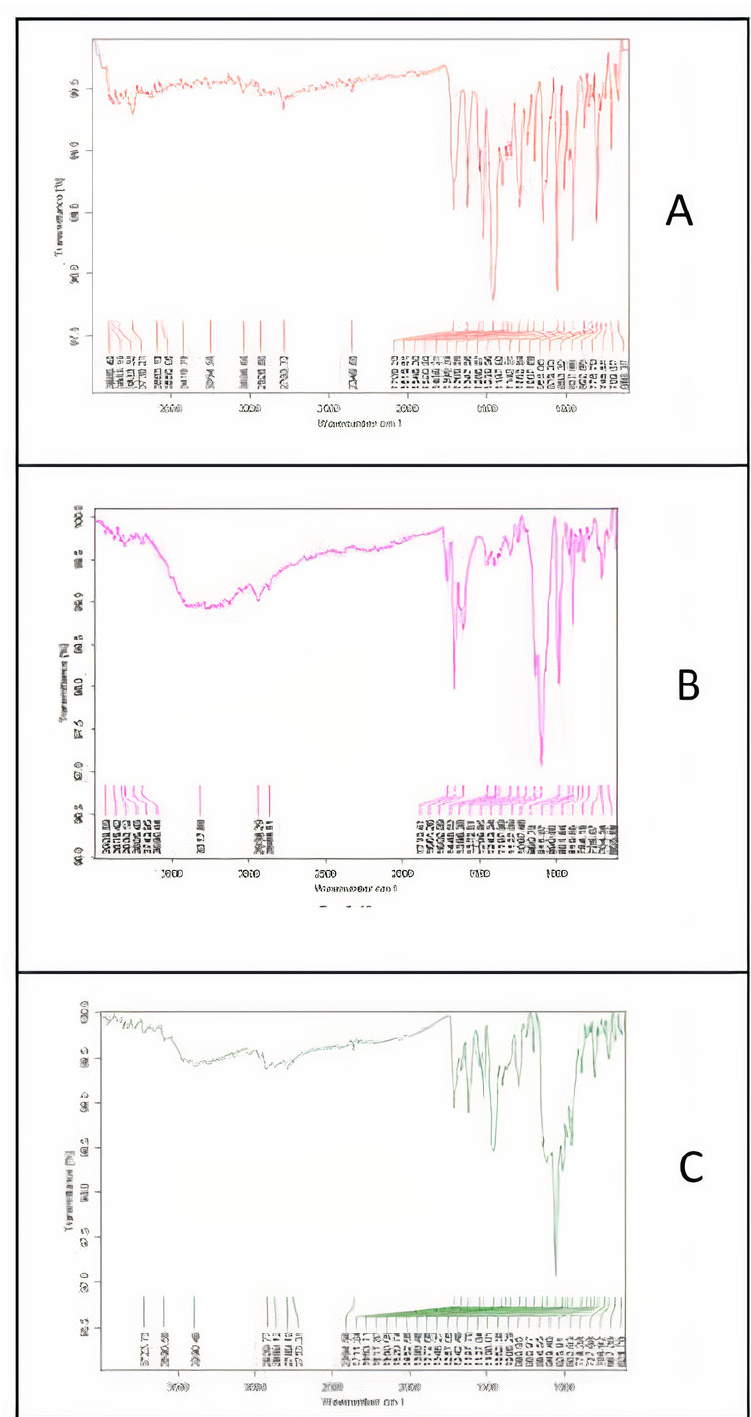
FIGURE 1 - (A) – FT-IR spectra for OFL. B) – FT-IR spectra for DX. (C) – FT-IR spectra for